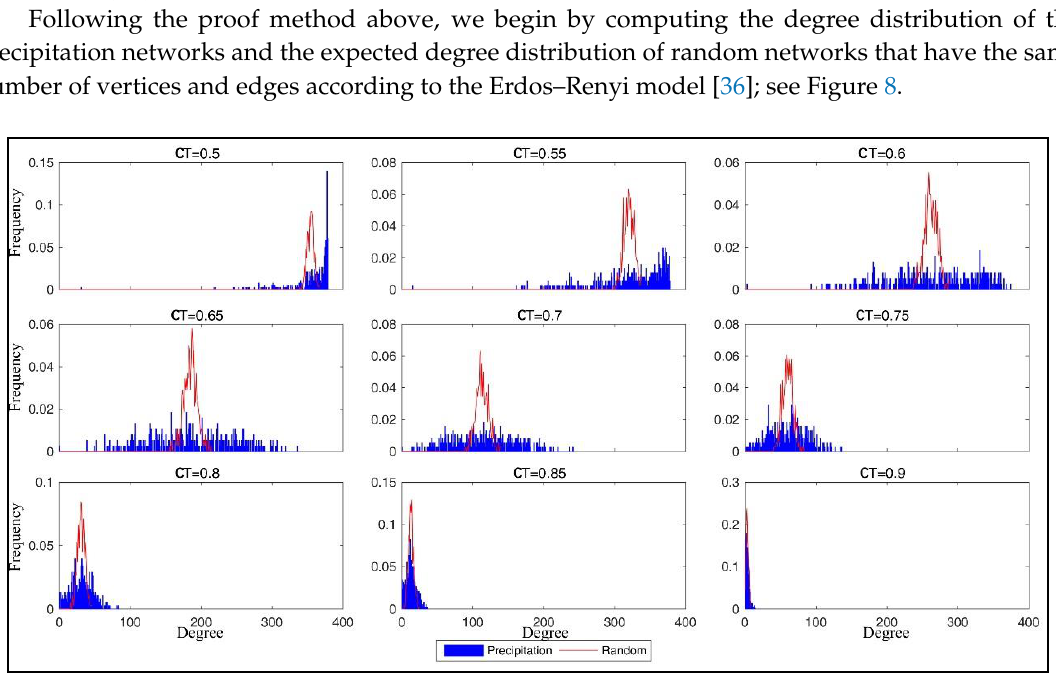
Table 4. The global clustering coefficient and the average path length for the P-network.